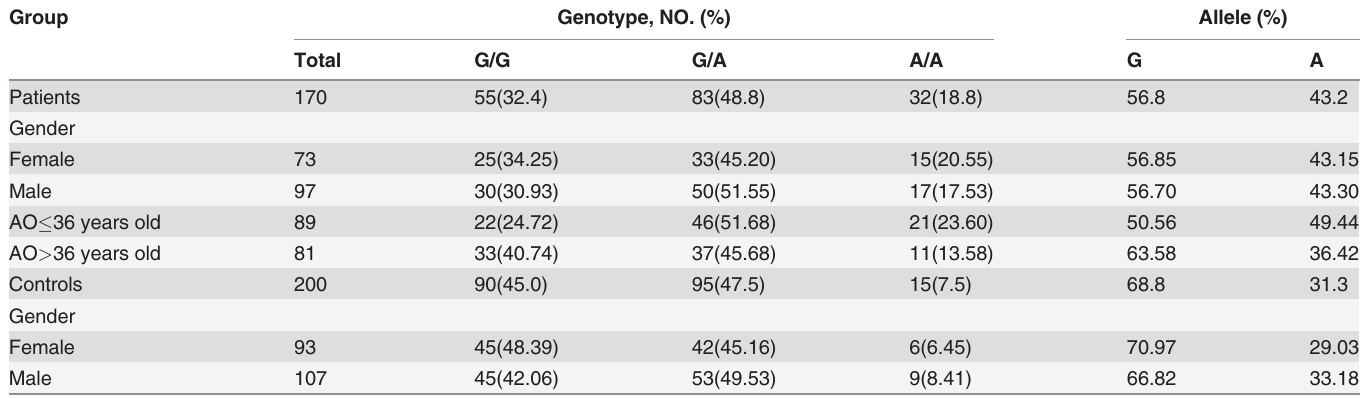
Table 2. Genotype and allele frequencies of rs709930 in SCA3/MJD patients and healthy